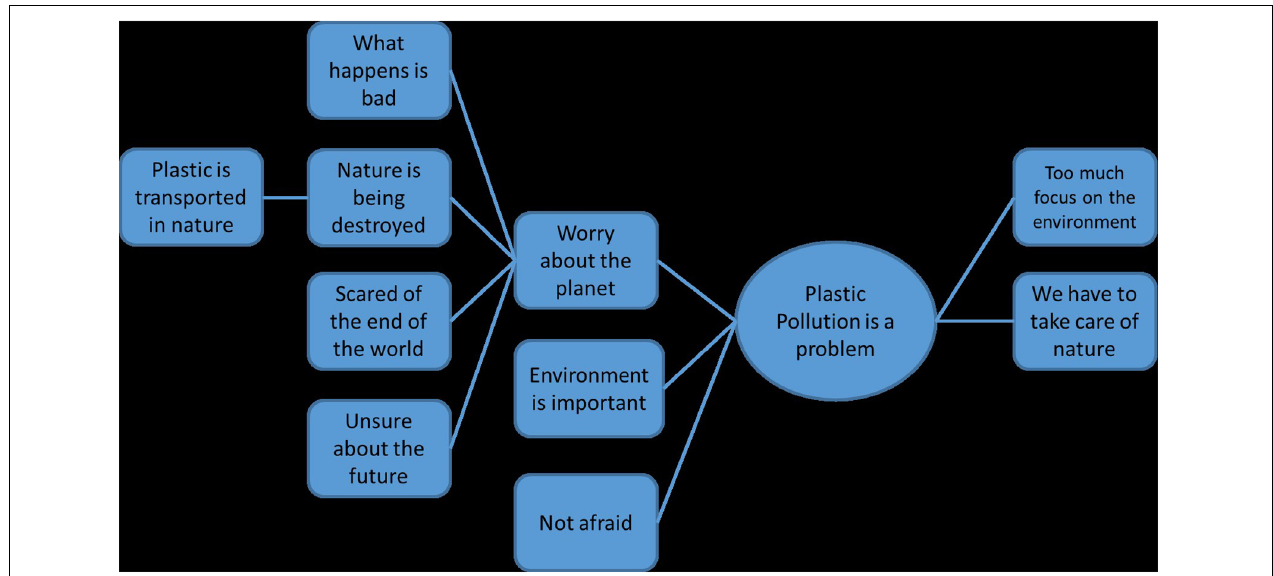
FIGURE 2 | Example for a mind map created by nVivo 12 software (translated from Norwegian by IR).